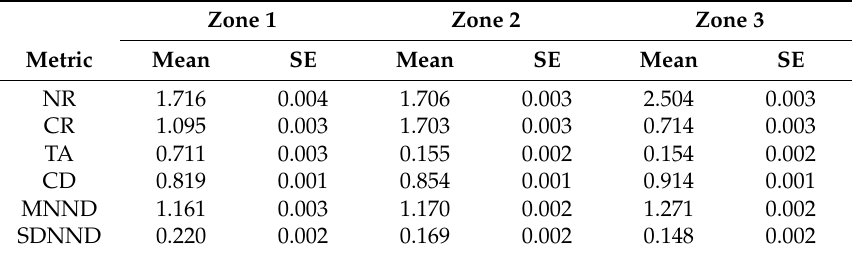
Table 1. The mean and standard error (SE) of Layman metrics of the Bayesian estimates of the areas defined by δ 15 N and δ 13 C of seston and plankton for each zone identified in Figure 1 (all depth layers combined). NR: δ 15 N range, CR: δ 13 C range, TA: total area of the convex hull, CD: mean